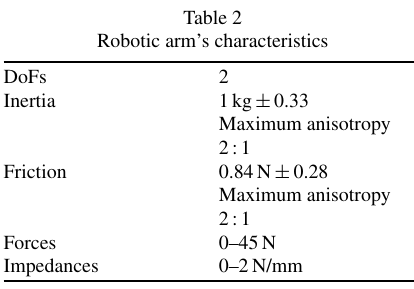
Fig. 1. A subject during the robot-aided